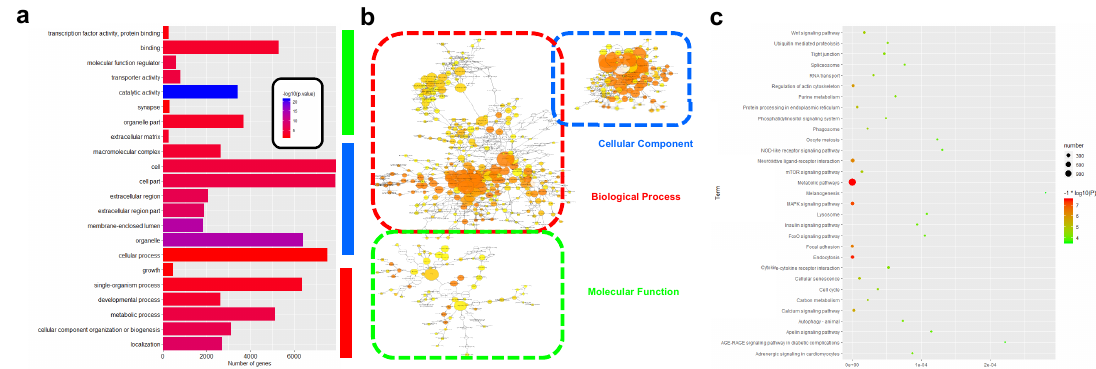
Figure 4. Functional enrichment analysis results of spliced genes during male germ cell differentiation. ( a ) The significantly enriched ( p < 0.05) first-class GO terms cluster of AS genes that were alternatively spliced in all cell types. The red line represents the biological process terms; the blue line represents cellular component terms; and the green line represents molecular function terms. ( b ) The enriched GO terms network. Each term is represented by a circle node, where its size is proportional to the number of AS genes, and its color represents its cluster identity. ( c ) The top 30 enriched KEGG pathway of AS genes that were alternatively spliced in all cell types.